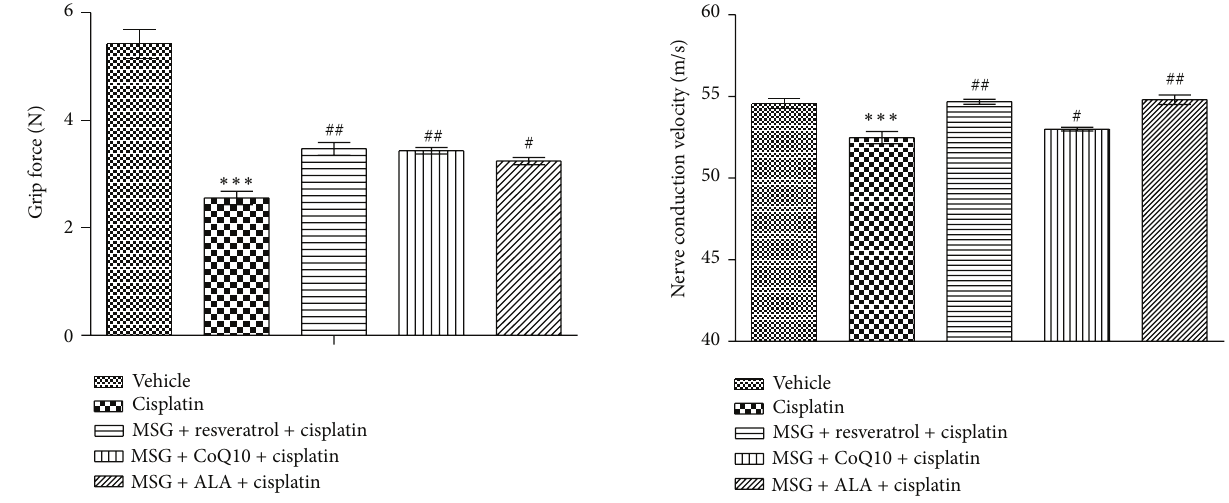
compared with cisplatin treated group. MSG + resveratrol treatment was the most effective in reducing the MDA level (Table